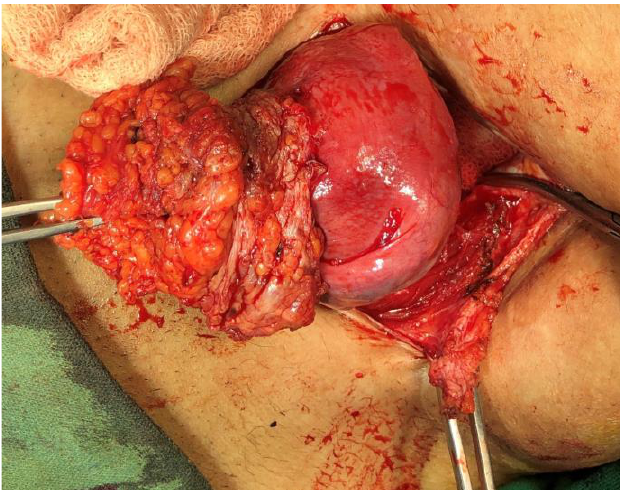
Figure 1. A lump of 5 × 3 cm encased in the fibrosis tissue, extending from the subcuticular plane, infiltrating the rectus sheath, and extending up to the anterior surface of the uterus.